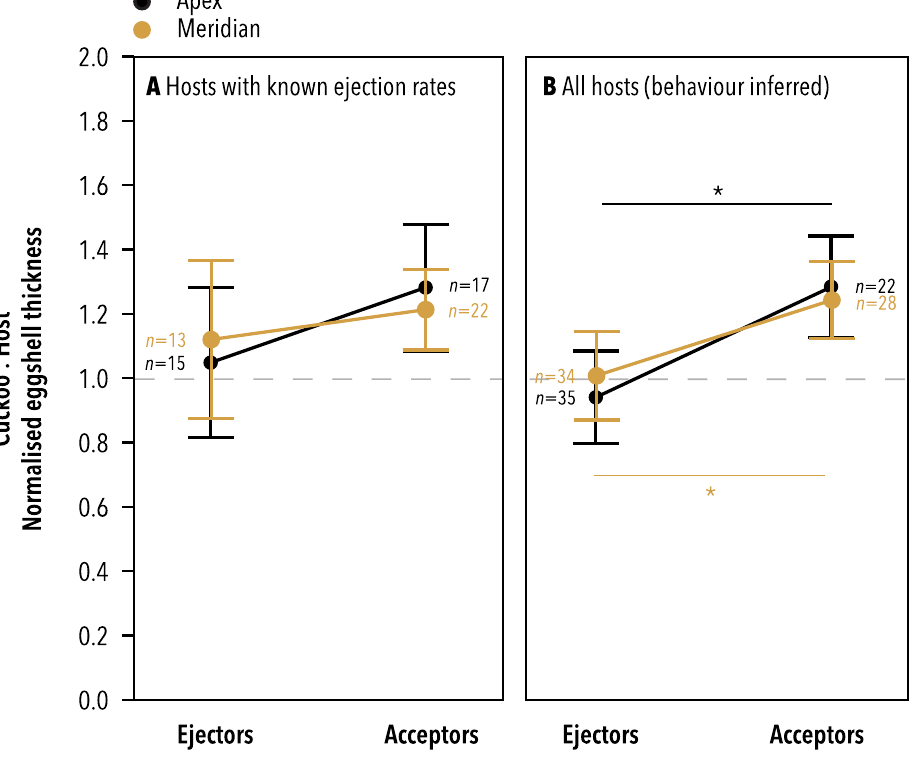
Figure 1. The ratio of normalised eggshell thickness between cuckoos and their ejector versus acceptor hosts. ( A ) In the smaller sample size dataset that includes only hosts with known egg ejection rates, there is no significant difference in the cuckoo:host ratio of eggshell thickness between acceptors and ejectors at either point measured (apex: F 1,1.98 = 2.31, P = 0.27; meridian: F 1,5.6 = 0.99, P = 0.36). ( B ) When all hosts are considered and ejection behaviour is inferred from nest type, cuckoos that exploit acceptor hosts have thicker eggshells relative to their hosts than cuckoos that exploit ejectors, at both the apex ( F 1,12.47 = 7.72, P = 0.02) and the meridian of the egg ( F 1,14.32 = 8.86 , P =